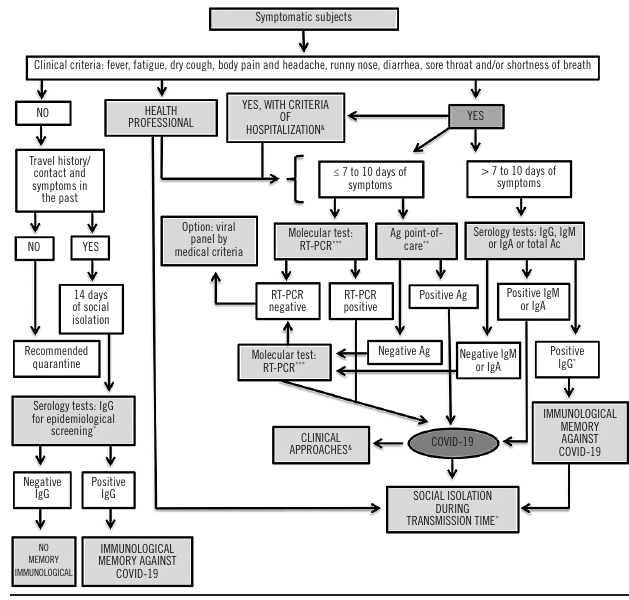
FIGURE 3 – Laboratory approach of individuals suspected of COVID-19 Source: By the authors. IgM: immunoglobulin class M; IgA: immunoglobulin class A; IgG: immunoglobulin class G; Ac: antibodies; Ag: antigen; RT-PCR: real-time polymerase chain reaction; * transmission